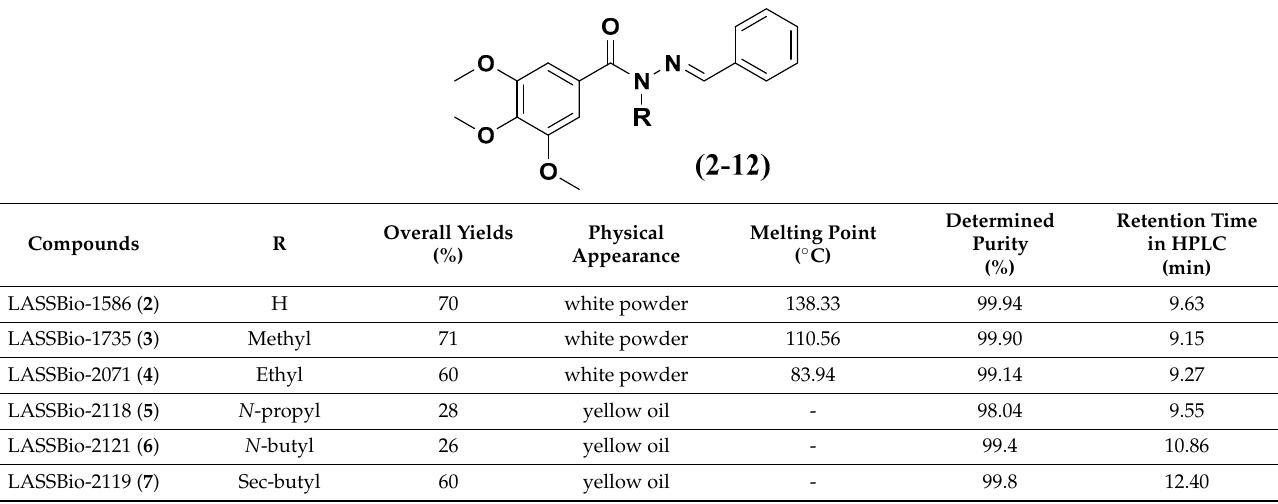
Figure 2. Synthetic methodology to obtain LASSBio ‐ 1586 ( 2 ) homologs and analogues from the starting material 13 . Table 1. Overall yields, physical aspect, melting point, purity by HPLC and retention time of compounds 2 – 12 .